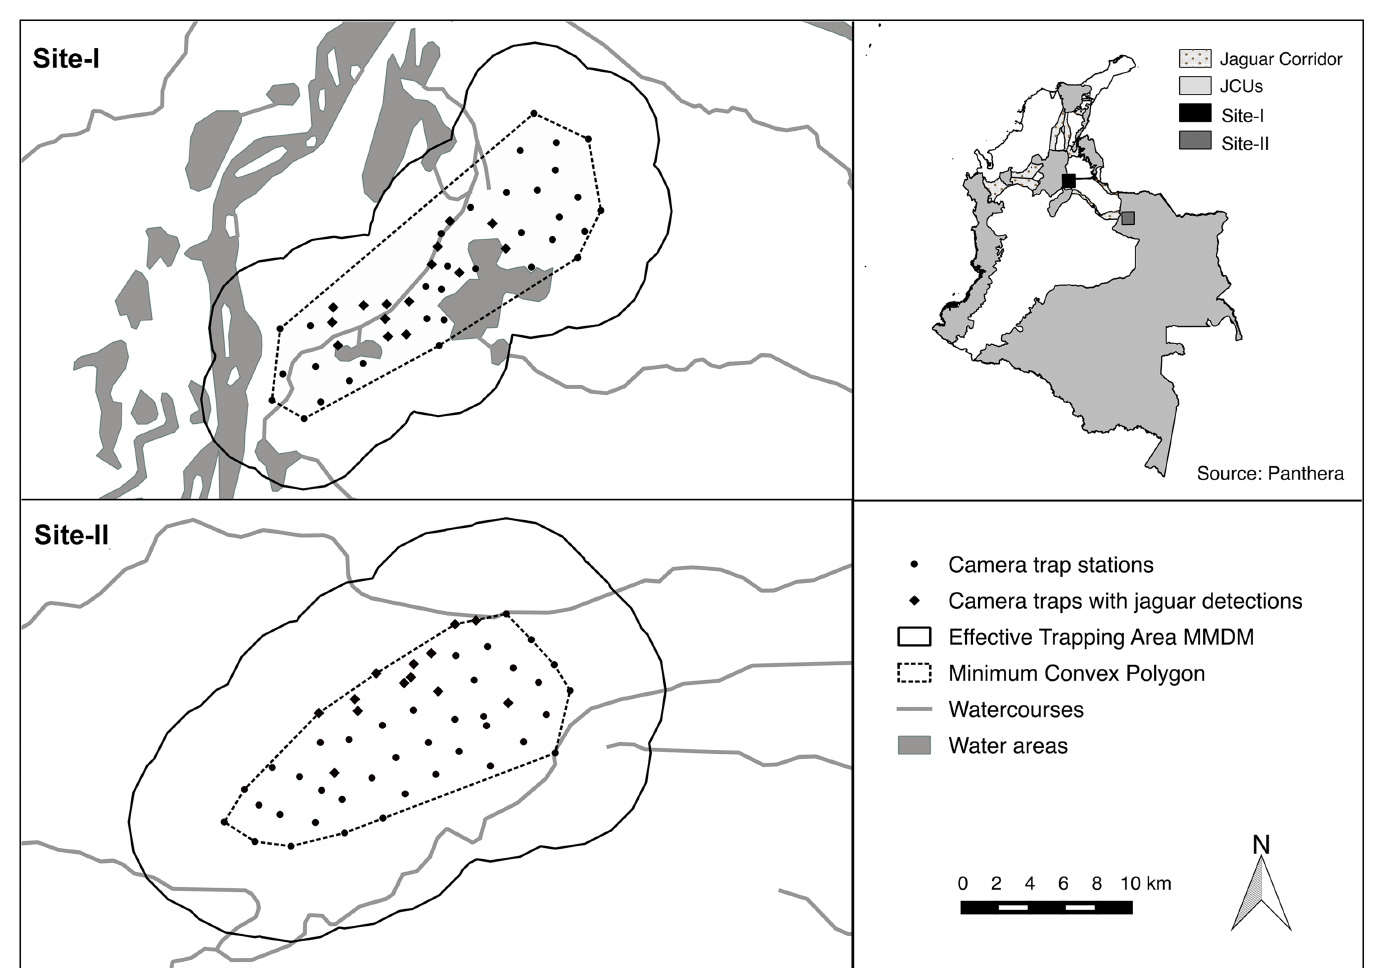
Fig 1. Study areas. Location of the sites in regard to the Jaguar Corridor and Jaguar Conservation Units (JCUs) in Colombia [15,24,33], and map of the study sites with camera locations. Site-1 is part of the Magdalena River valley, while Site-2 is located in the Orinoco River basin. Both sites were surveyed in